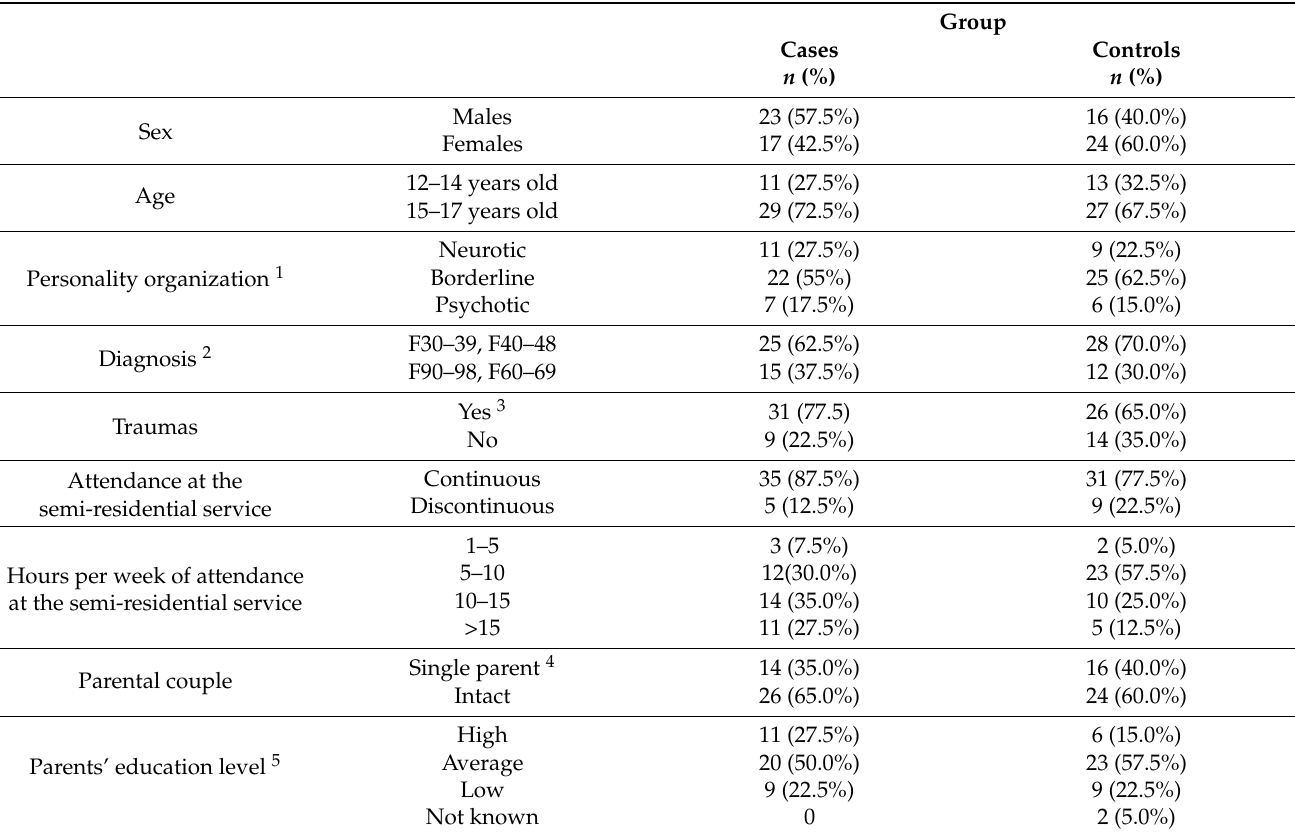
Table 1. Frequencies of the characteristics of the case and control